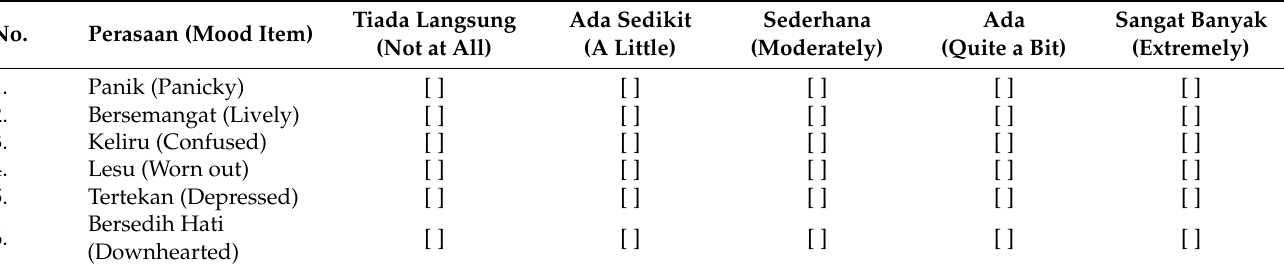
Table A1. Malaysian Mood Scale